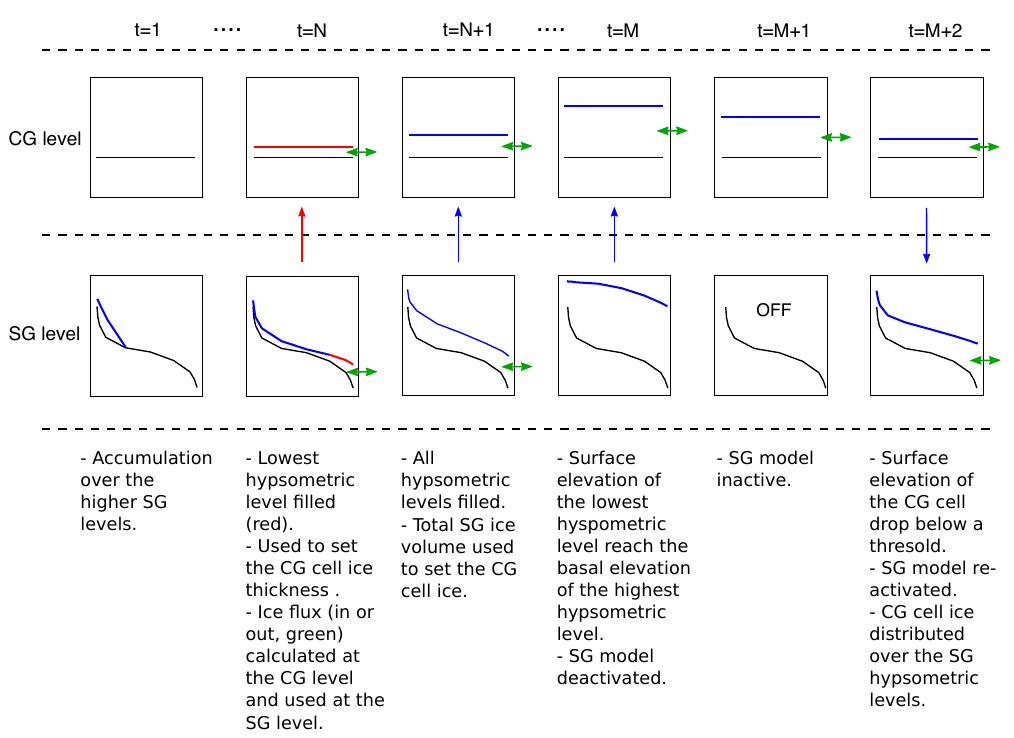
Figure 2. Communication between the GSM and the SG model for one CG